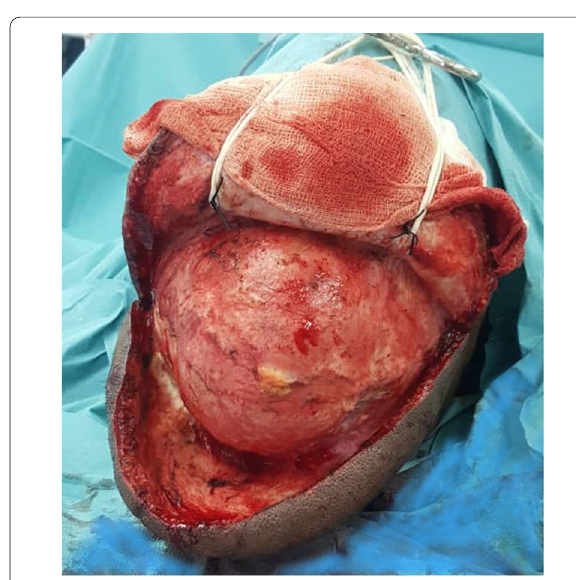
Fig. 3 Scalp skin being incised transversely, pnematocele s intact beneath the periosteum